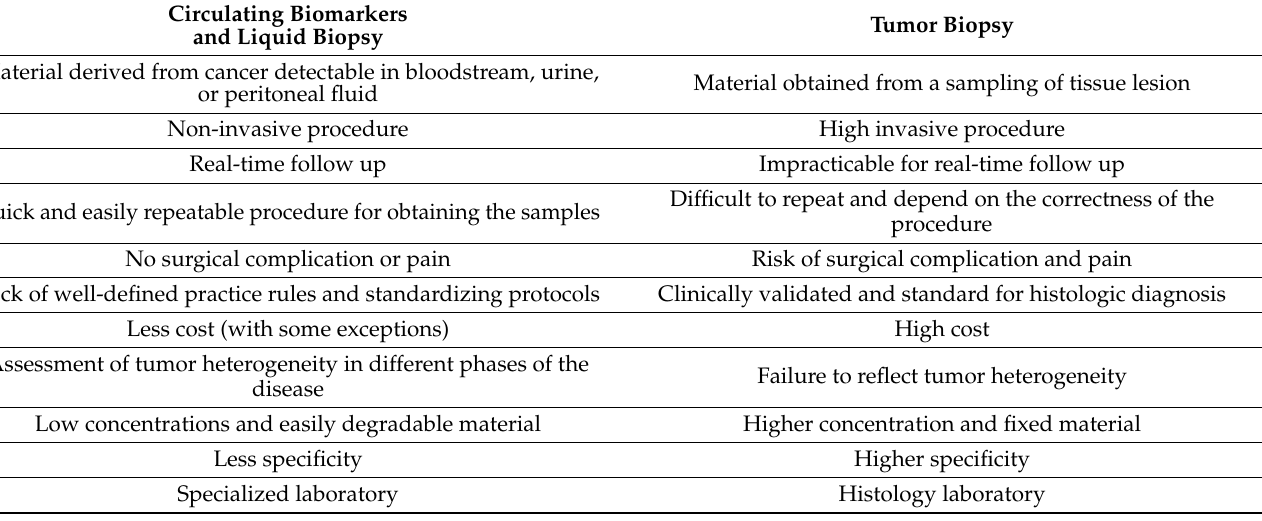
Table 1. Characteristics of circulating biomarkers and tumor biopsy.